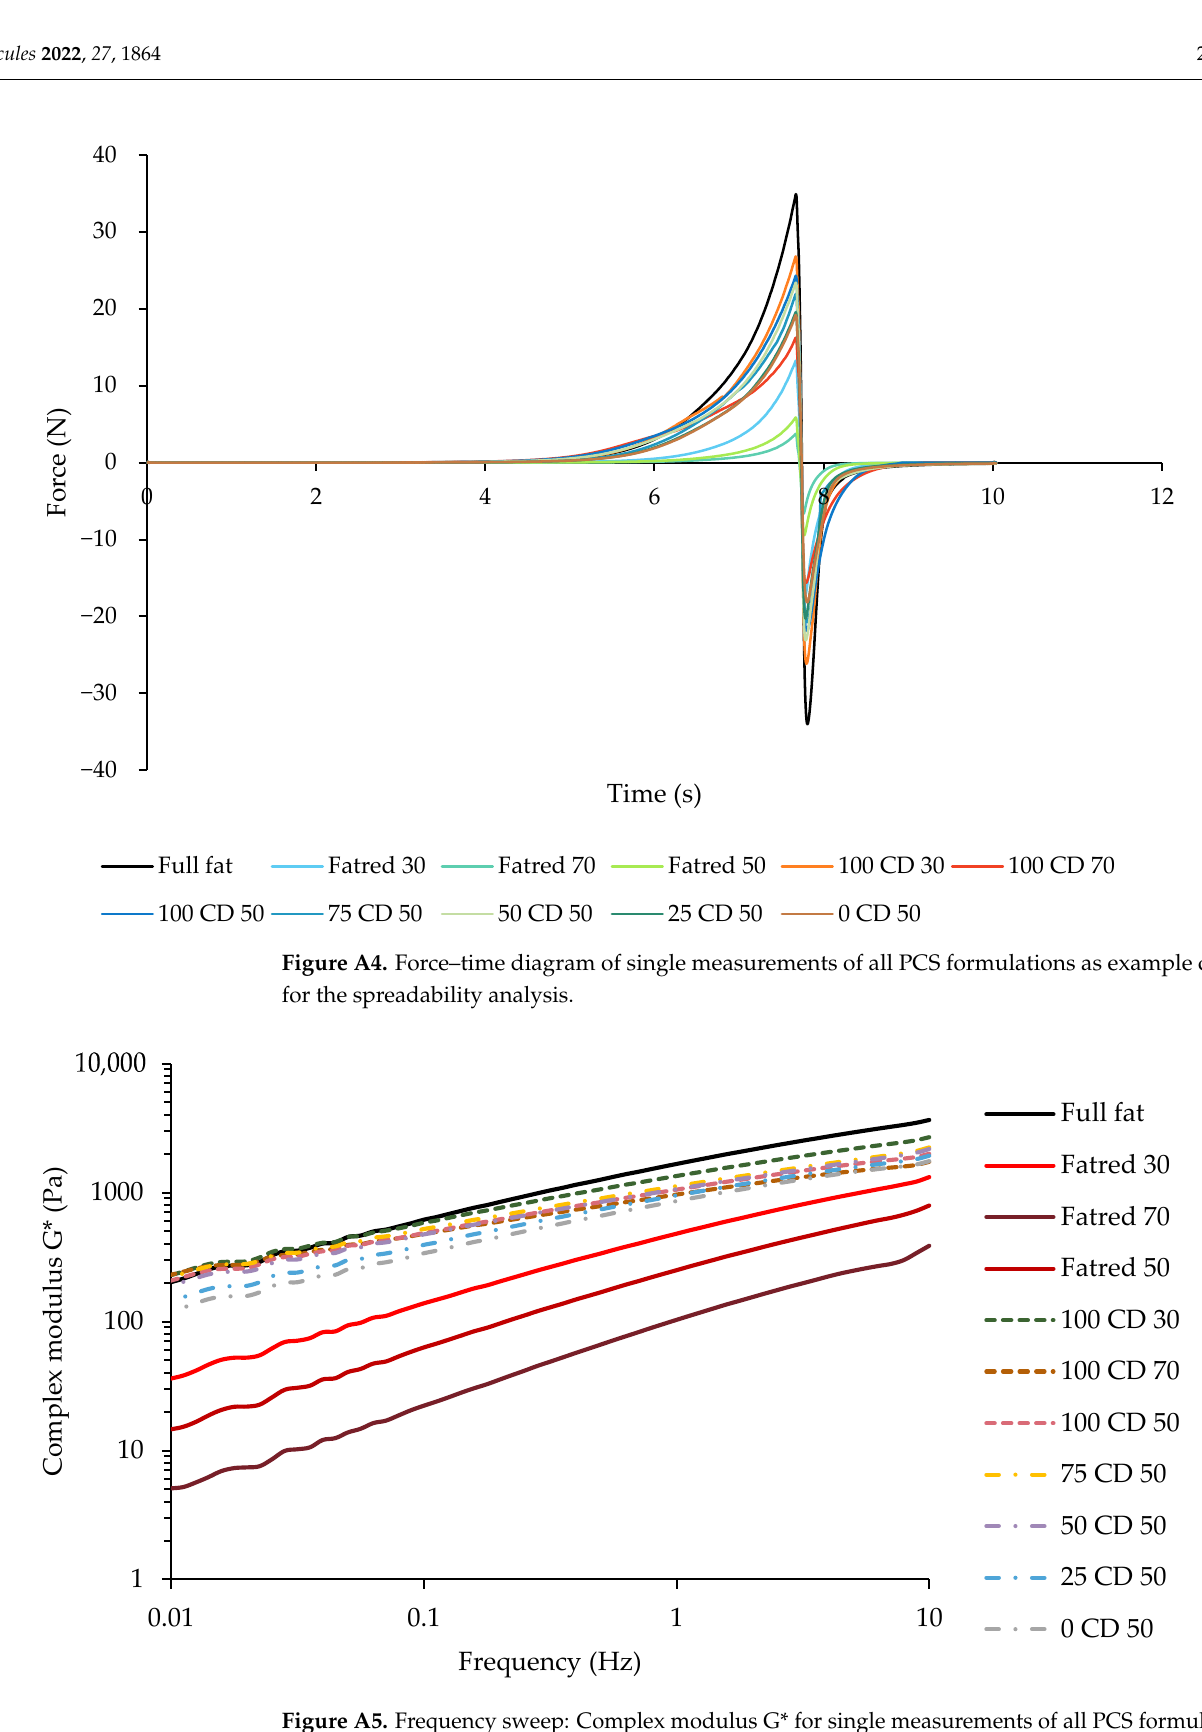
Figure A5. Frequency sweep: Complex modulus G* for single measurements of all PCS formulations as example curves for dynamic oscillatory rheological analysis.